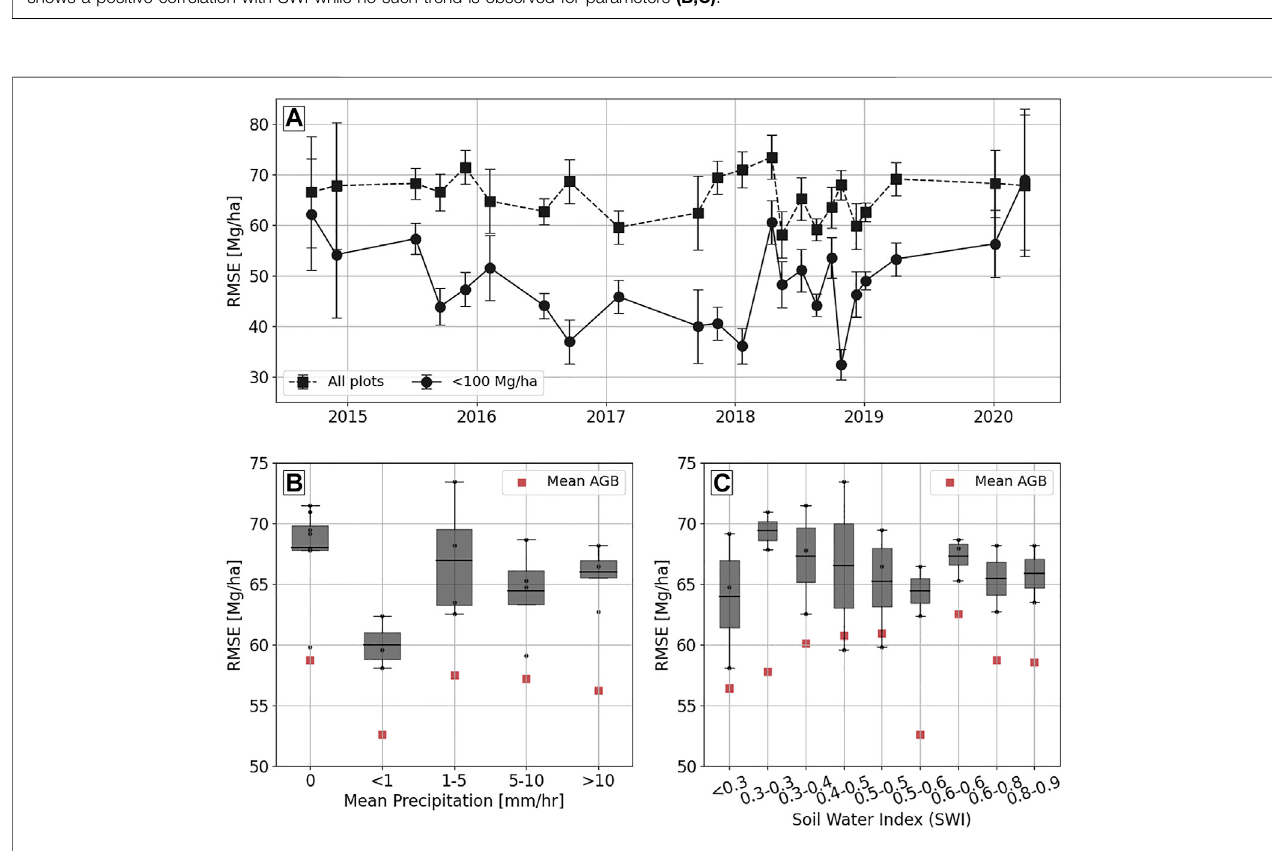
FIGURE 9 | (A) The root mean squared error (RMSE) of the estimated AGB with respect to the fi eld AGB for each ALOS-2/PALSAR-2 acquisition measured for all fi eld plots and for plots with AGB less than 100 Mg/ha. (B,C) assess the impact of mean precipitation (72 h before acquisition) and SWI on model estimated AGB error.